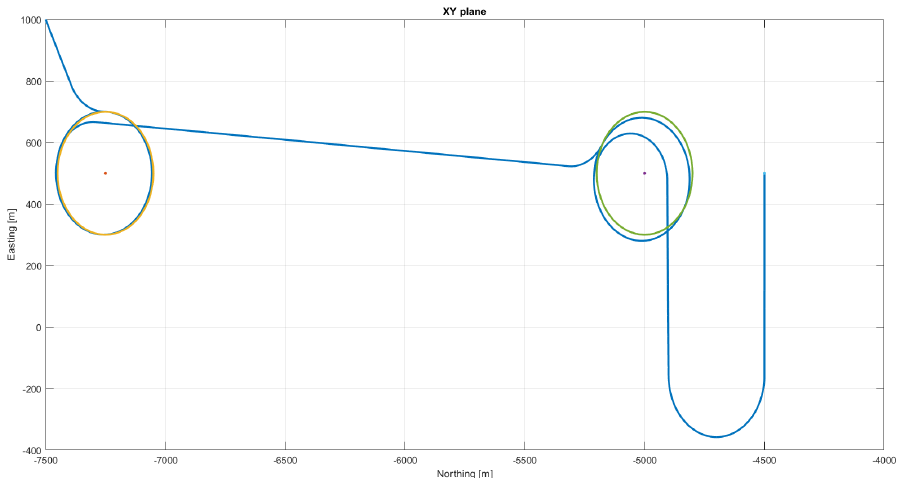
Figure 14. Guidance trajectory view in the xy